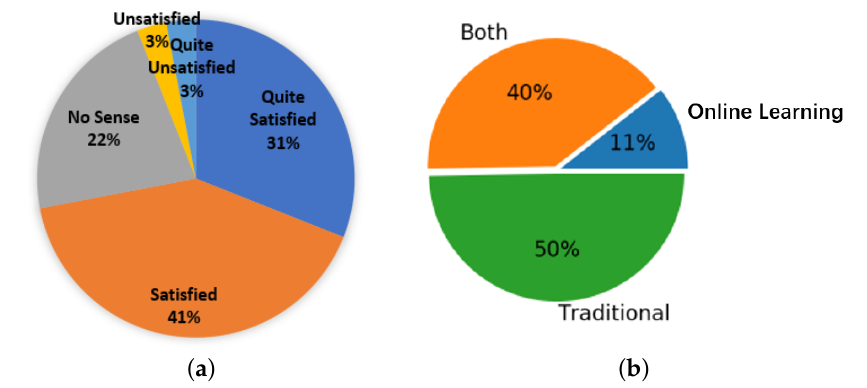
Figure 2. Students’ satisfaction with the learning platform. ( a ) Satisfaction with the platform. ( b ) Offline and online preferences.